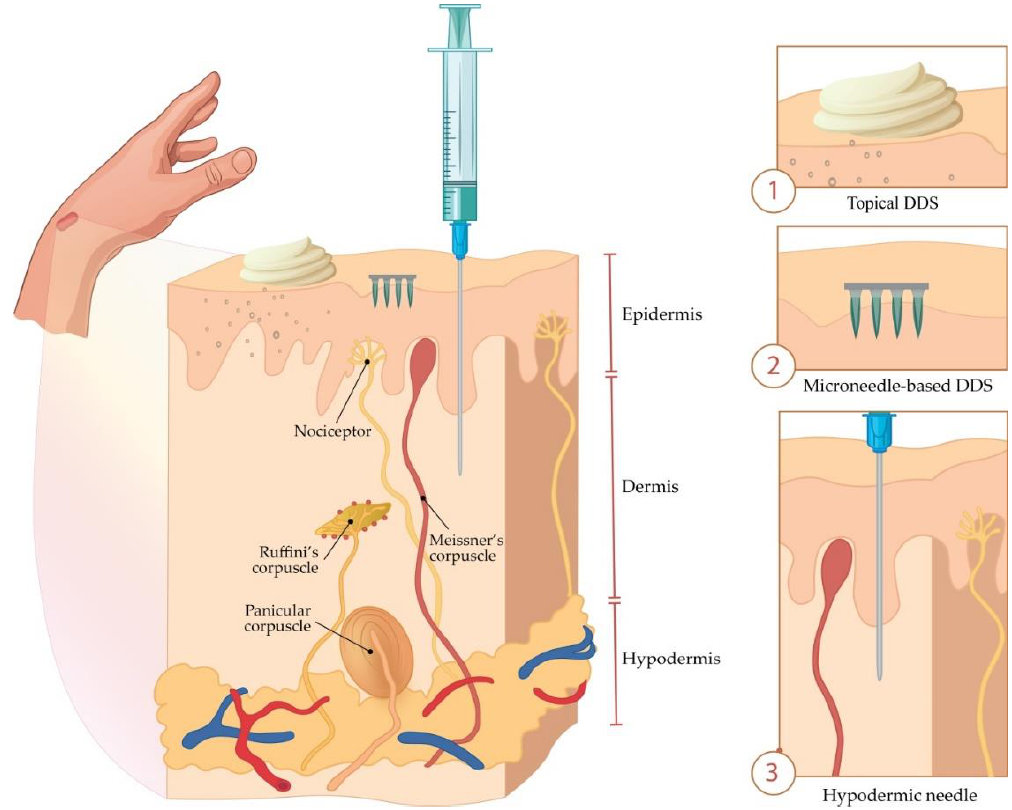
Figure 1. Comparison of drug delivery systems (DDS) based on (1) the conventional topical formulation, (2) microneedles (MNs), and (3) hypodermal injection.